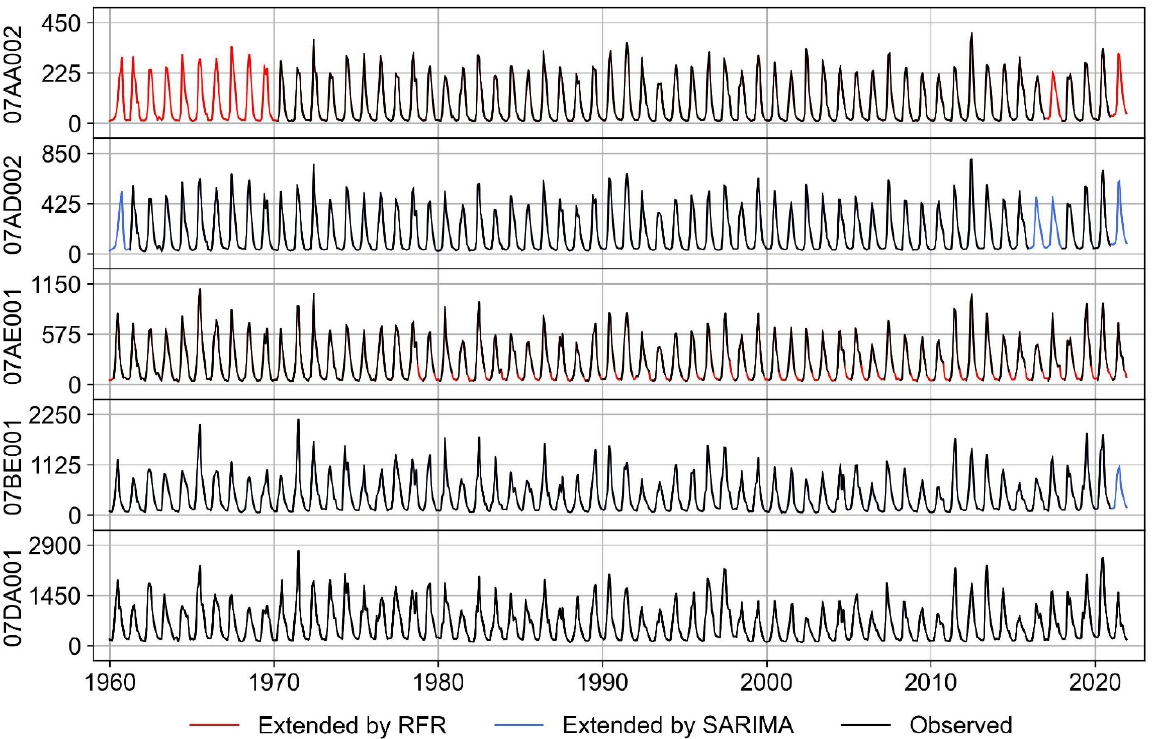
Figure 4. The observed and extended streamflow (m 3 /s) monthly time series through SARIMA (solid blue line) and RFR (solid red line) modeling for 07AA002 (Athabasca River near Jasper), 07AD002 (Athabasca River at Hinton), 07AE001 (Athabasca River near Windfall), 07BE001 (Athabasca River at Athabasca), and 07DA001 (Athabasca River below Fort McMurray).